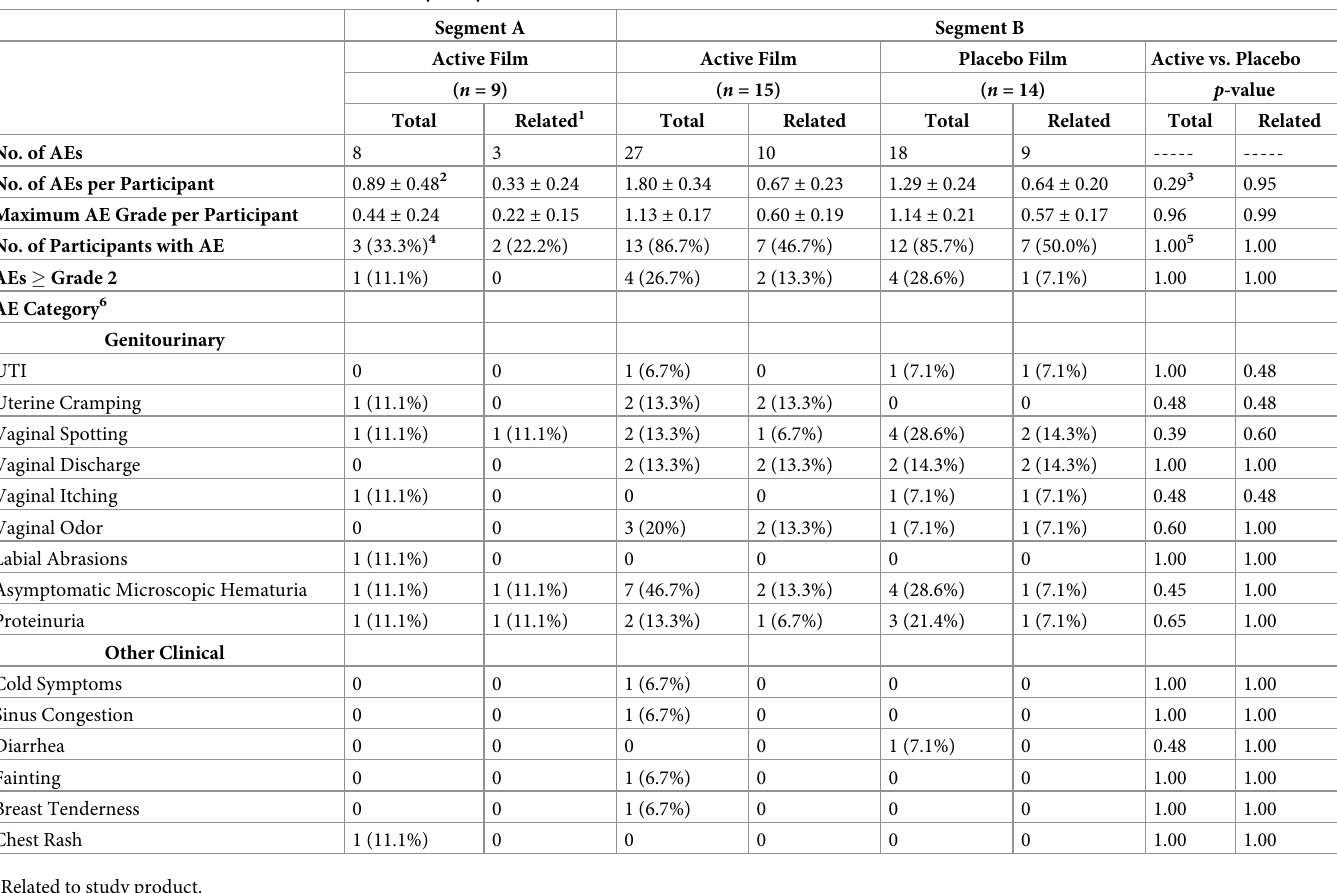
Table 2. Distribution and nature of adverse events by study